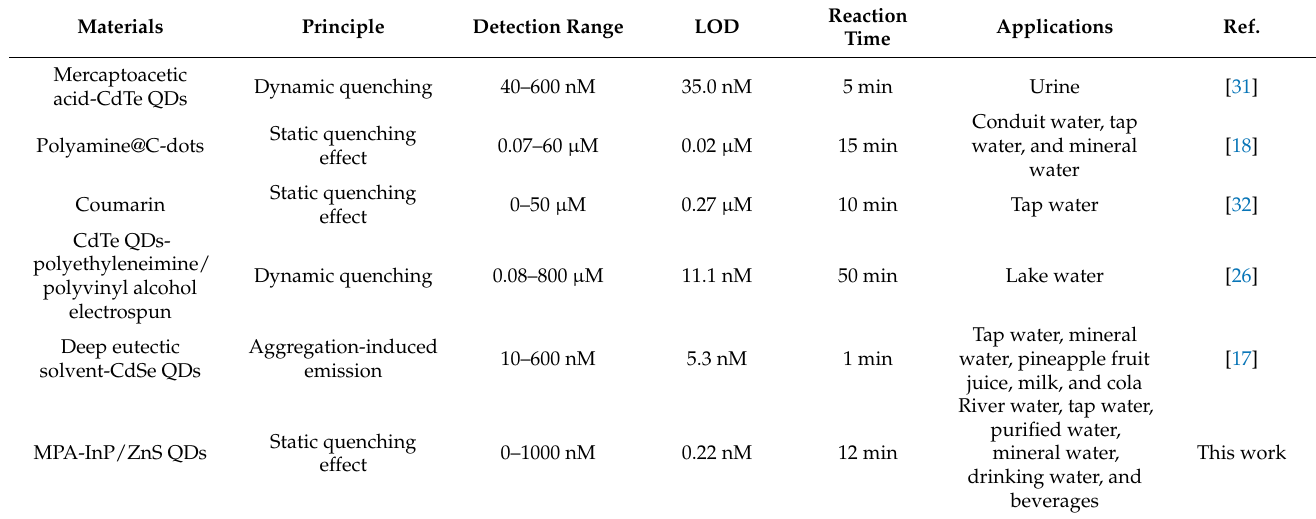
Table 3. Comparison of the performance of fluorescent MPA-InP/ZnS QDs probes for the detection of Cu 2+ .